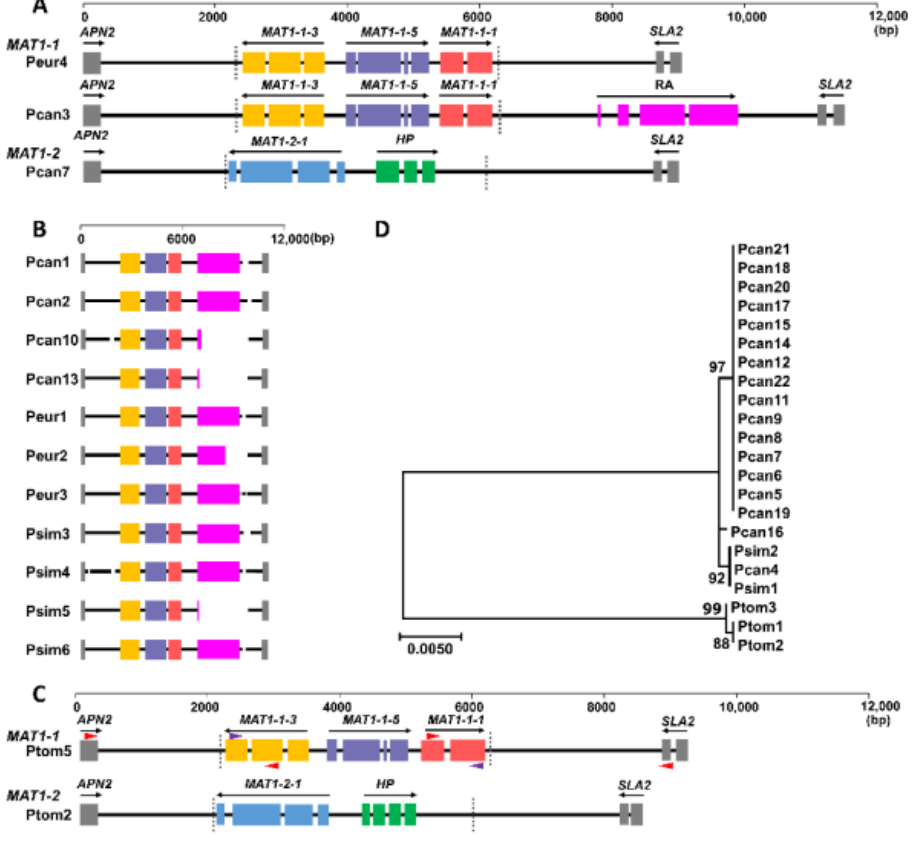
Figure 4. The MAT loci of M. brunnea. ( A ) Structures of the MAT1-1 and MAT1-2 loci of MbMu . Solid boxes represent the coding regions of the predicted genes interrupted by introns. Black arrows indicate the orientations of the coding sequences. Dotted lines mark the sizes of the unique sequences of the idiomorphs. ( B ) A simple diagram of MAT1-1 loci of 11 MbMu isolates. The correspondence of box colors and predicted genes are consistent with that seen in (A). The interruption of the solid line represents the gap in the assembly. ( C ) Structures of the MAT1-1 and MAT1-2 loci of MbMo . Triangles represent primers used to clone MAT1-1 of MbMo . Purple triangle, primers designed based on MAT1-1 sequence of MbMu ; red triangle, primers designed based on MAT1-1 sequence of MbMo . ( D ) Phylogenetic tree constructed with MAT1-2 idiomorph sequences. The tree was constructed using the maximum likelihood method and tested with 1000 bootstrap replicates.